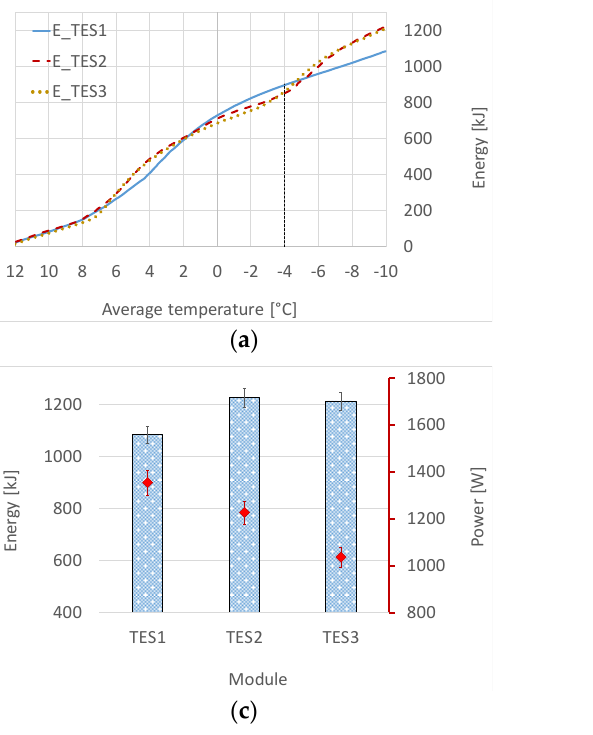
Figure 5. Results of the charging process: ( a ) energy stored against average temperature, ( b ) total energy stored and average charging power from 12 °C to − 4 °C, ( c ) total energy stored and average charging power from 12 °C to − 10 °C, and ( d ) COP of the refrigeration system against average temperature.